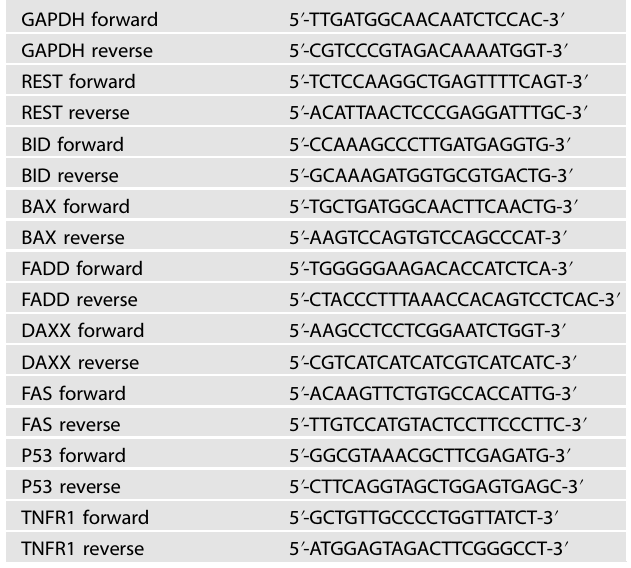
Table 1. The primers sequences for